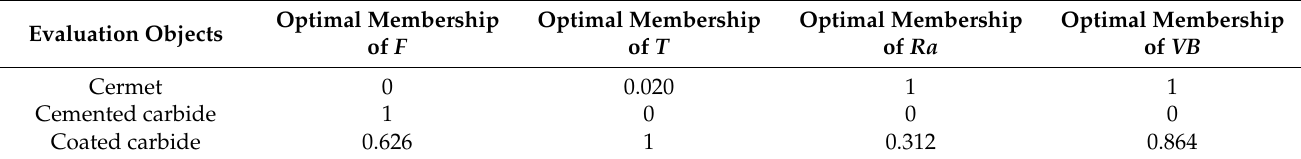
Table 7. Fuzzy membership of evaluation indexes at the cutting speed of 40 m/min.